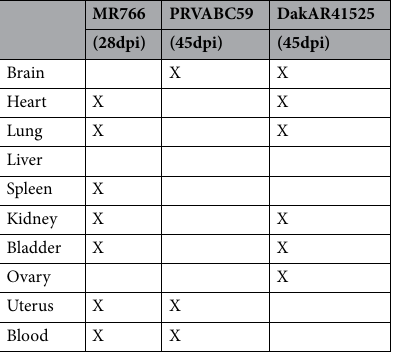
Table 2. Jamaican fruit bats from which ZIKV sfRNA was amplified and sequenced (n = 3). One animal was inoculated with each of three strains of ZIKV and euthanized at varying timepoints (e.g. female bat inoculated with MR766 euthanized at 28